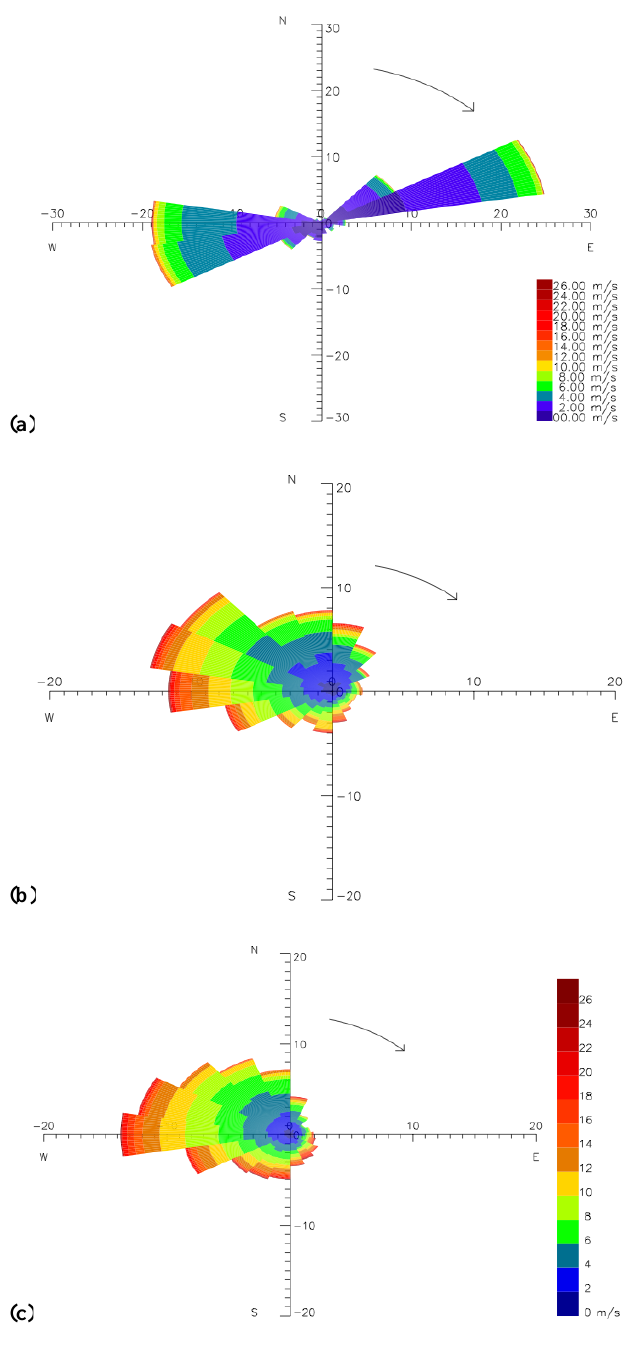
Figure 2. (a) Wind rose recorded at the Lamezia Terme surface station from 1 January 2007 to 31 December 2008. Color shading shows the wind intensity (ms − 1 ). (b) as in (a) for ECMWF analysis at 850hPa from 1 January 2007 to 31 December 2008. (c) Wind rose recorded 1700ma.g.l. by the UHF wind profiler form 1 June 2008 to 31 May